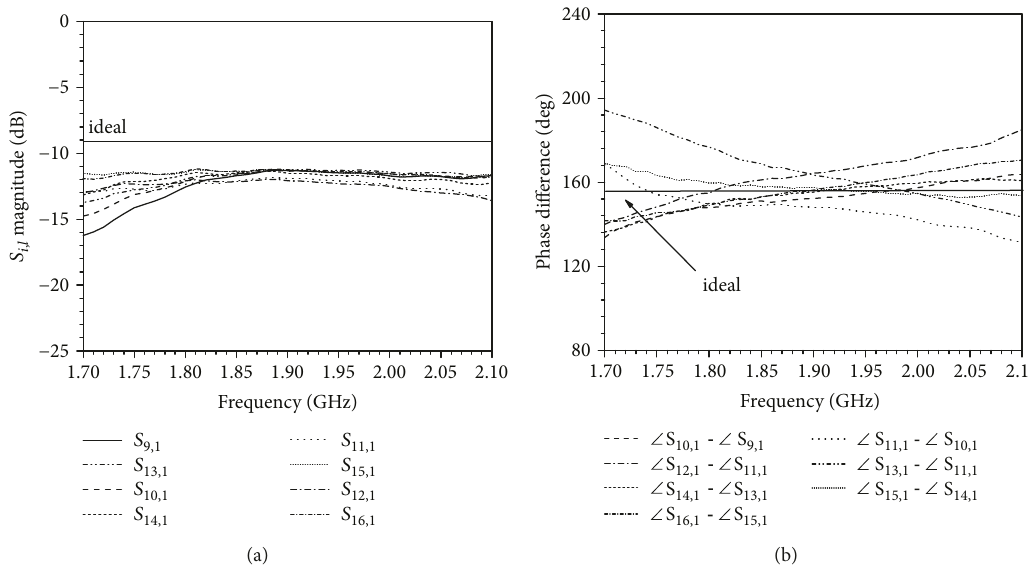
Figure 9: (a) Magnitude and (b) phase di ff erence of the S -parameters for the 8 × 8 BM when input port 1 is